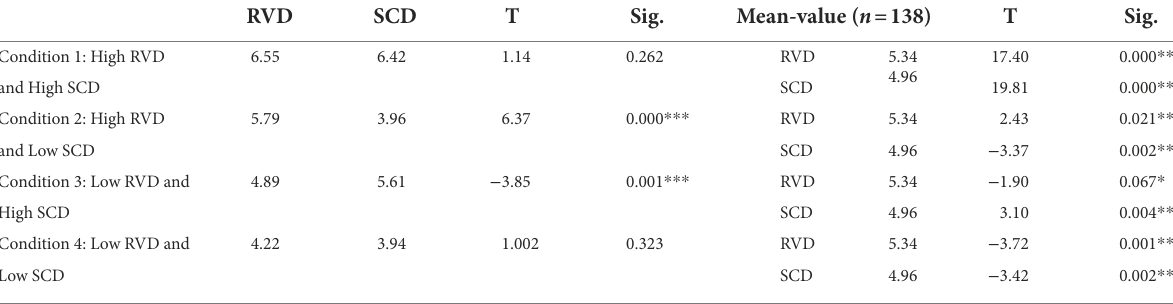
TABLE 1 Manipulation check of dependence.